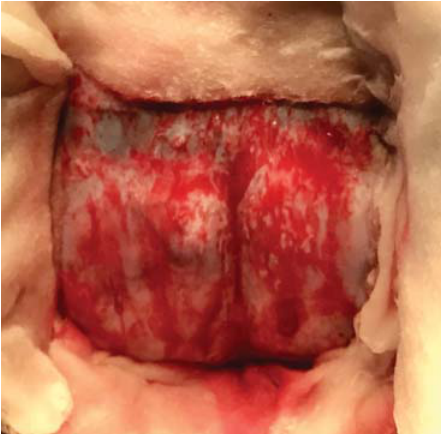
Figure 5: Dural exposure: must widely expose transverse sinus superiorly